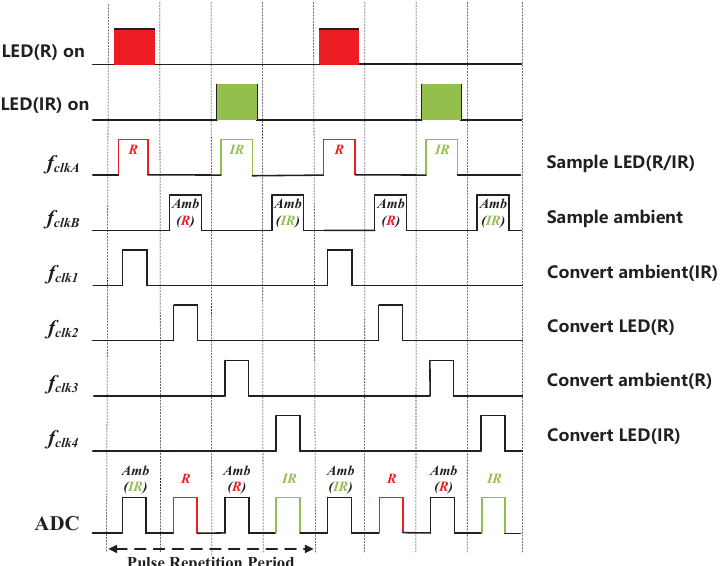
Figure 4. Timing diagram of AFE